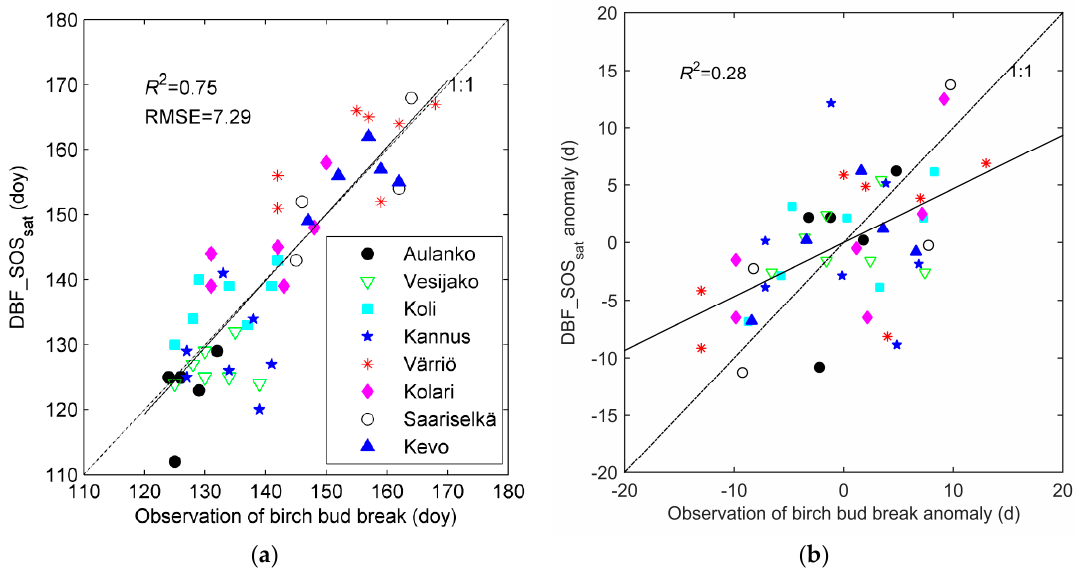
Figure 2. Relationship of the start of season in deciduous broad-leaf forests (DBF_SOS sat ) with phenological observations of birch bud break for the period from 2001 to 2008: ( a ) for all site-years and ( b ) for the year-to-year anomalies.